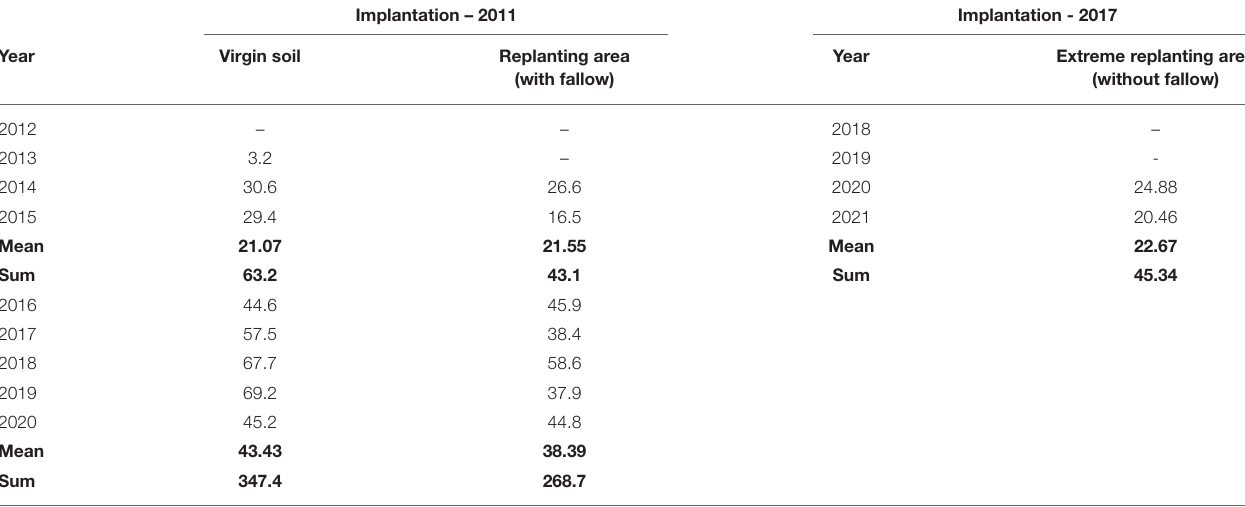
TABLE 1 | Yield of the Gala Select cultivar grafted on ‘G.213’, in the virgin area, the replanting area with fallow, and the replanting area without fallow in Vacaria. Implantation –